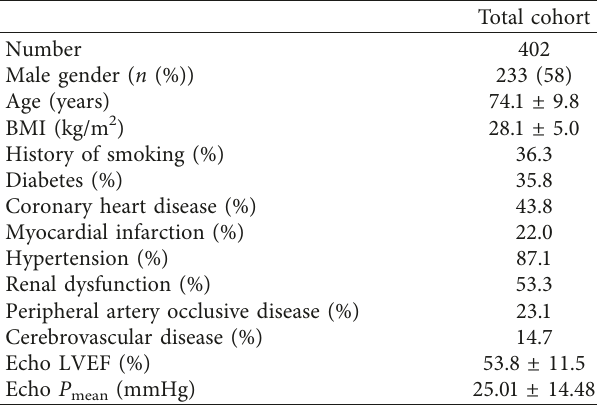
Table 1: Characteristics of the cohort at